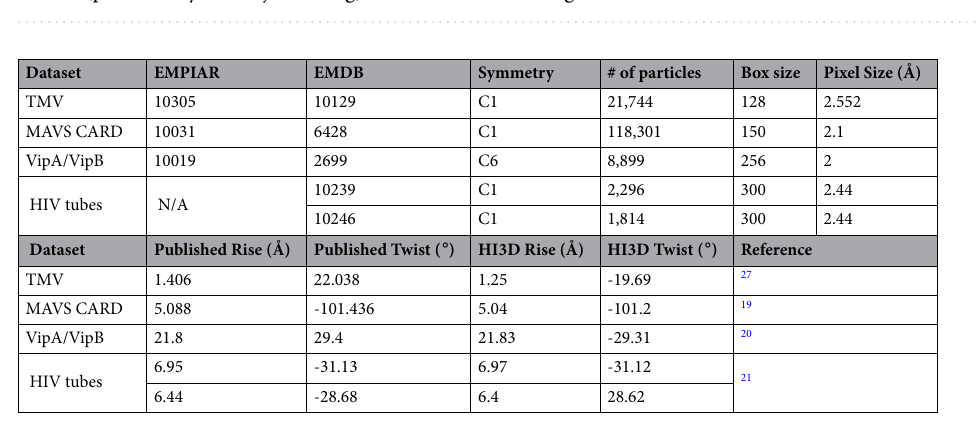
Figure 9. The surface view of the asymmetric reconstruction ( a ), the cylindrical projection ( b ), and the 2D lattice ( c ) with the HI3D outputted helical rise and twist and C-sym of the minor class of the HIV capsid protein dataset (provided by Dr. Peijun Zhang). The surface view was generated with UCSF Chimera 18 .